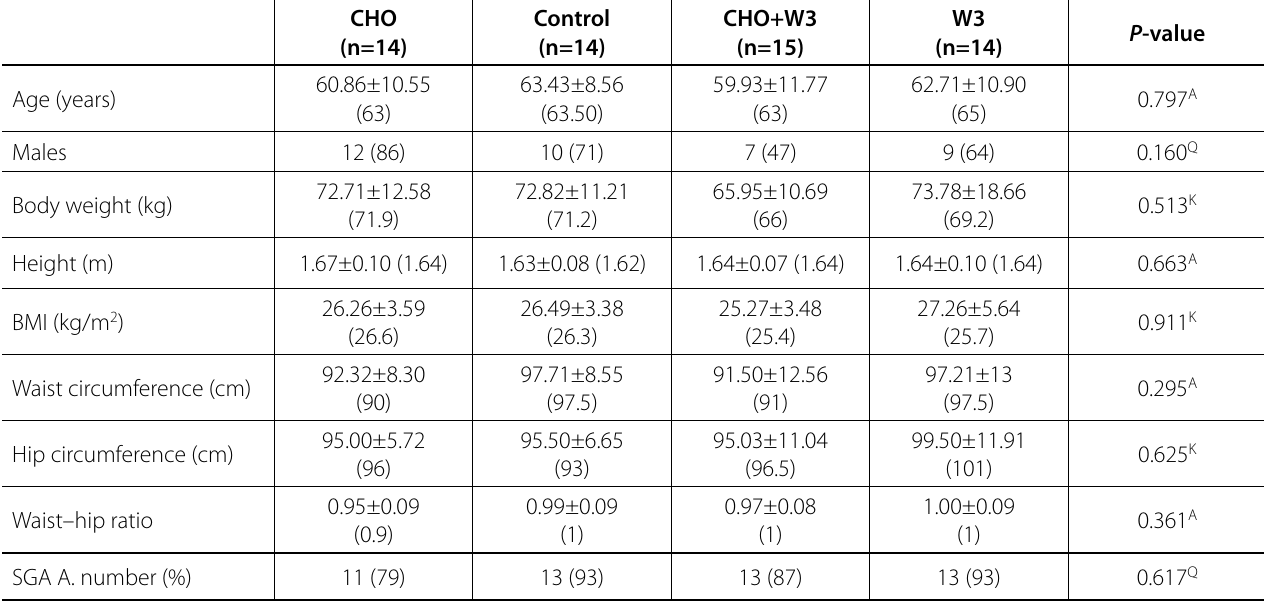
Table 1 . Demographic and anthropometric data of 57 patients undergoing on-pump CABG. CHO